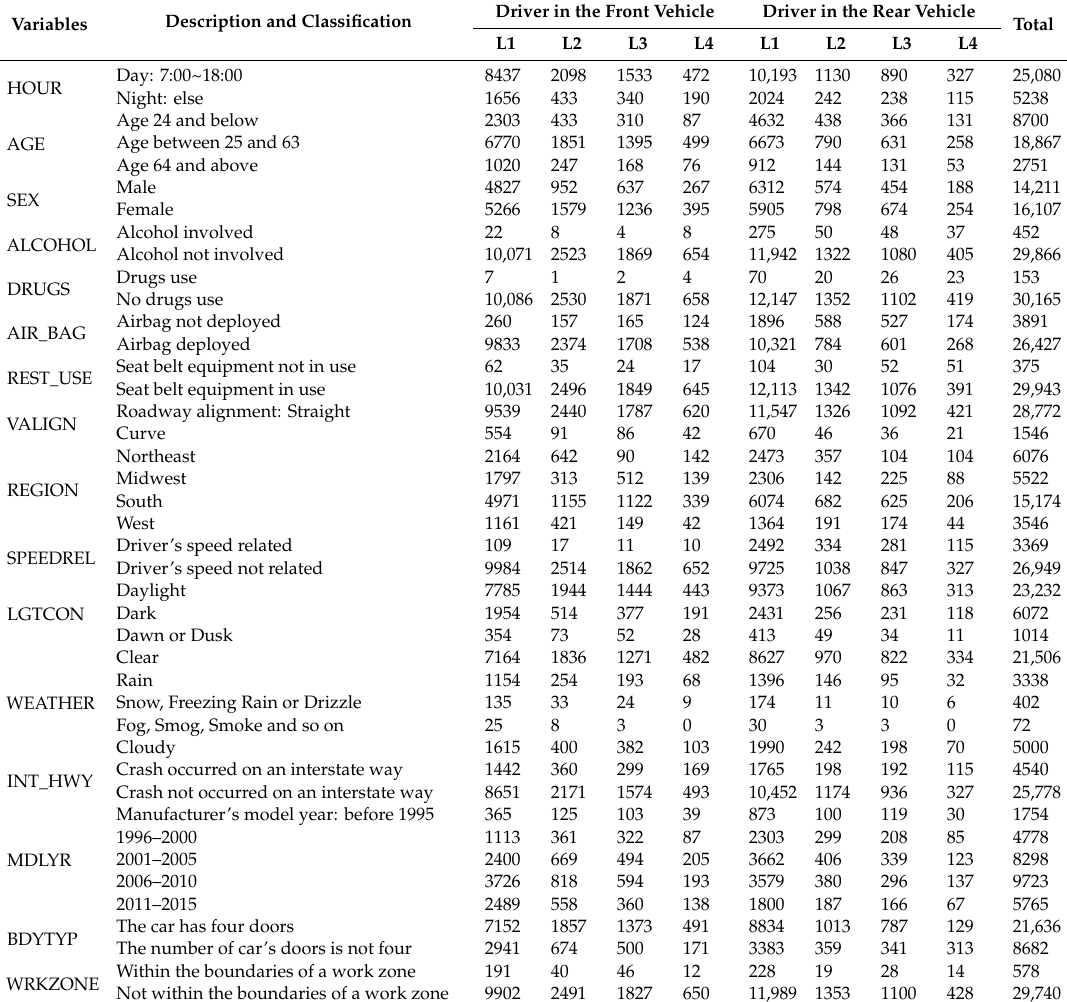
Table 2. Summary statistics for driver-related, vehicle-related and other independent